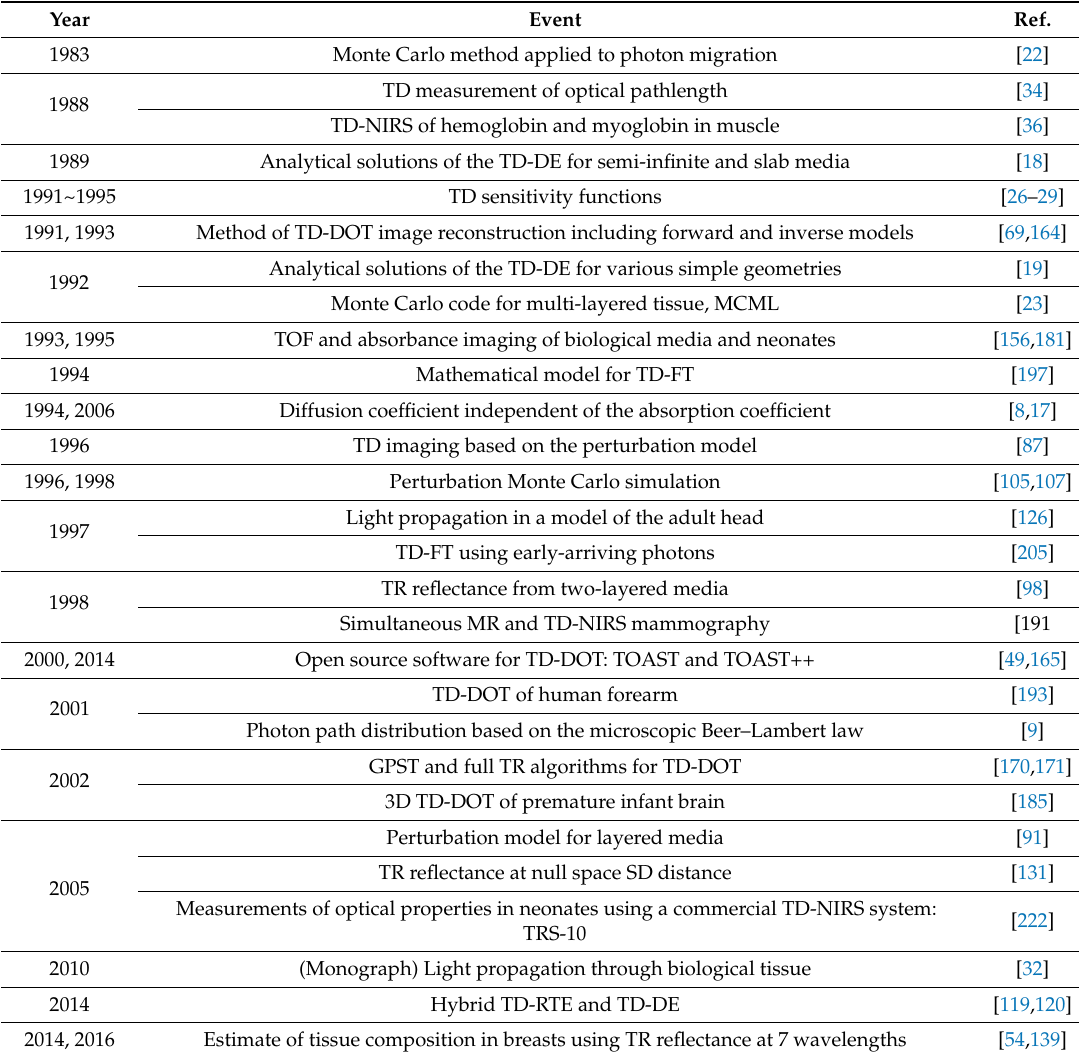
Table 2. Chronology of major events in theories, methods and applications of